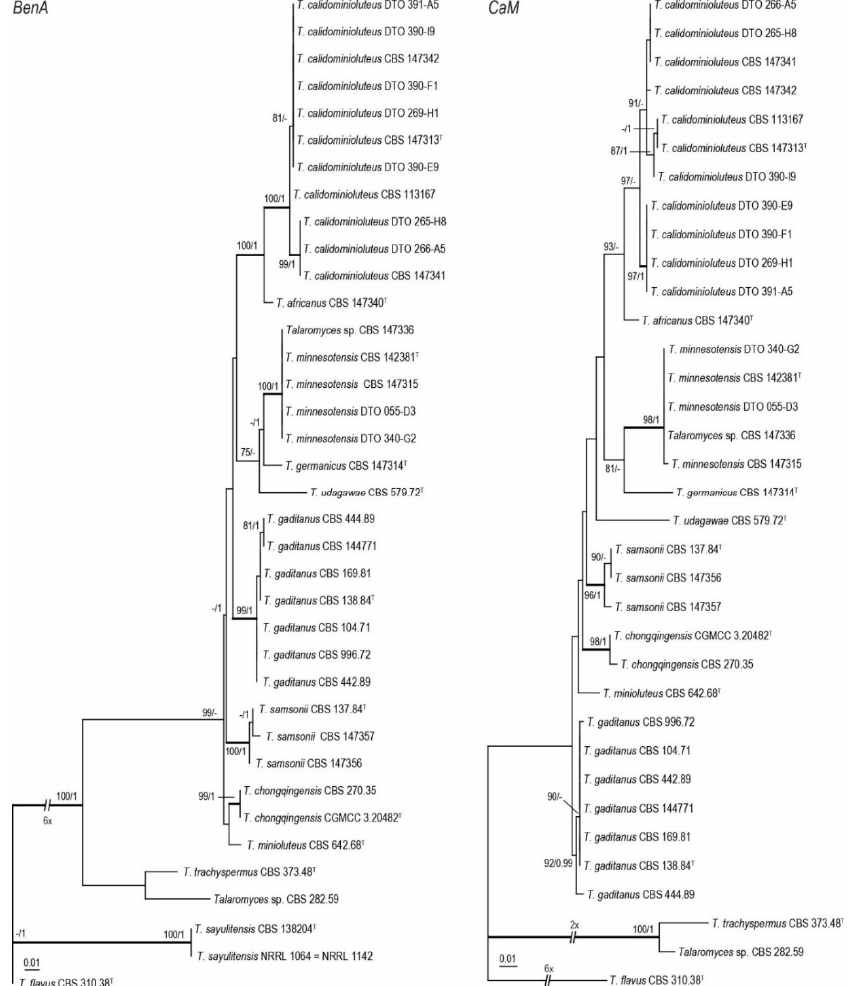
Figure 1. Maximum Likelihood (ML) tree based on BenA and CaM gene sequences depicting the relationships of T. minioluteus and related species. The BI posterior probabilities and ML bootstrap percentages are presented at the nodes (BS/PP) and the fully supported branches are thickened. Values less than 70% bs (ML) or less than 0.95 pp (Bayesian analysis) are indicated with a hyphen or not shown. The BenA phylogram is rooted with Talaromyces flavus (CBS 310.38 T ), T. sayulitensis (CBS 138204 T , NRRL 1142 [=NRRL 1064]), T. trachyspermus (CBS 373.48 T ) and Talaromyces sp. (CBS 282.59); the CaM phylogram with Talaromyces flavus (CBS 310.38 T ), T. trachyspermus (CBS 373.48 T ) and Talaromyces sp. (CBS 282.59). T =